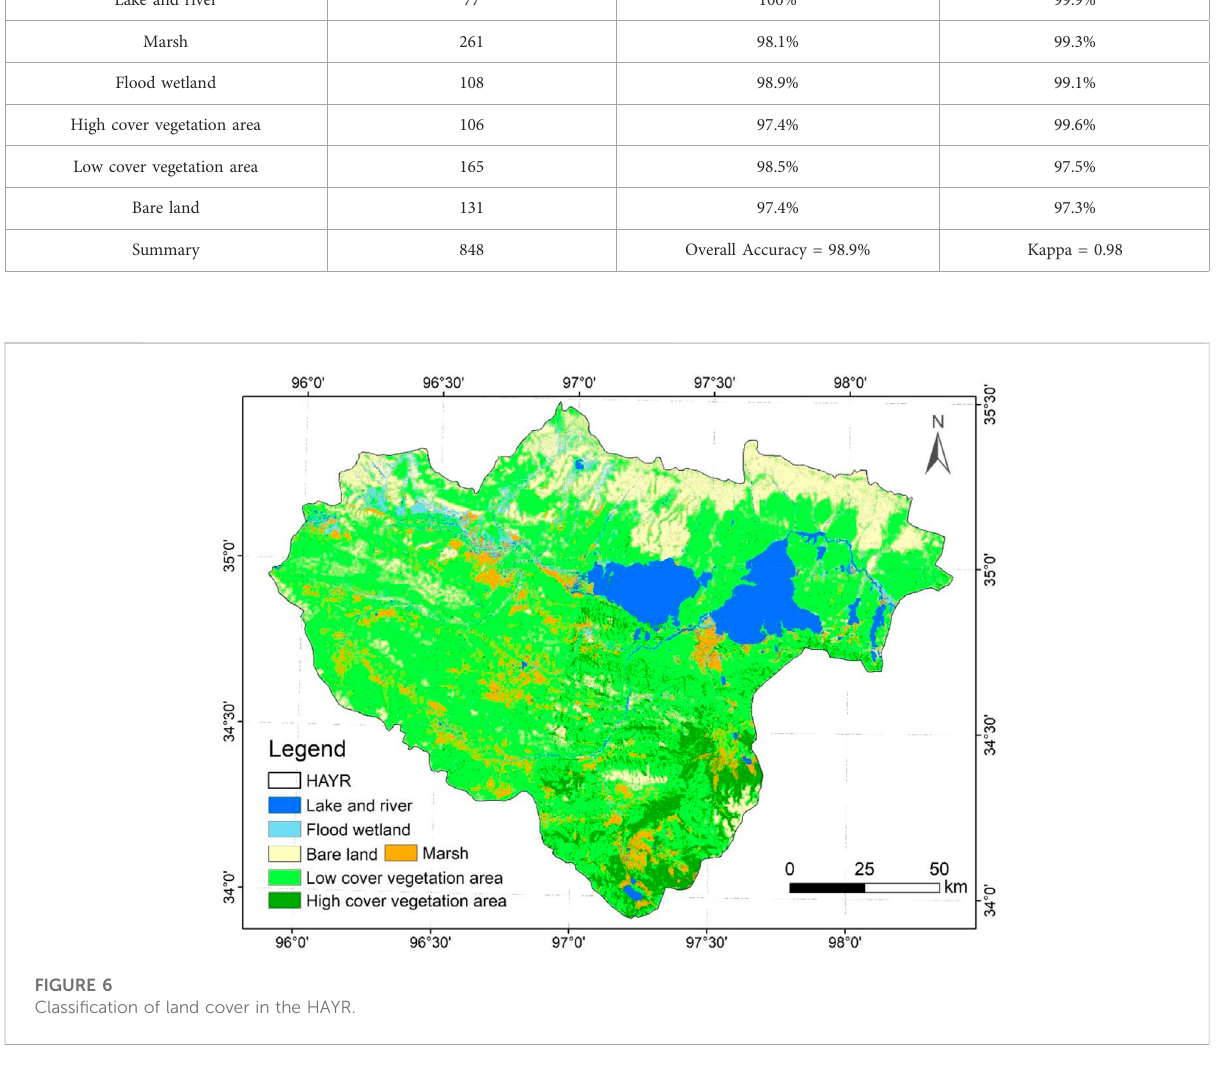
Figure 1. In this study, a total of 848 surface interest area samples were selected to verify the accuracy of the classi fi cation.